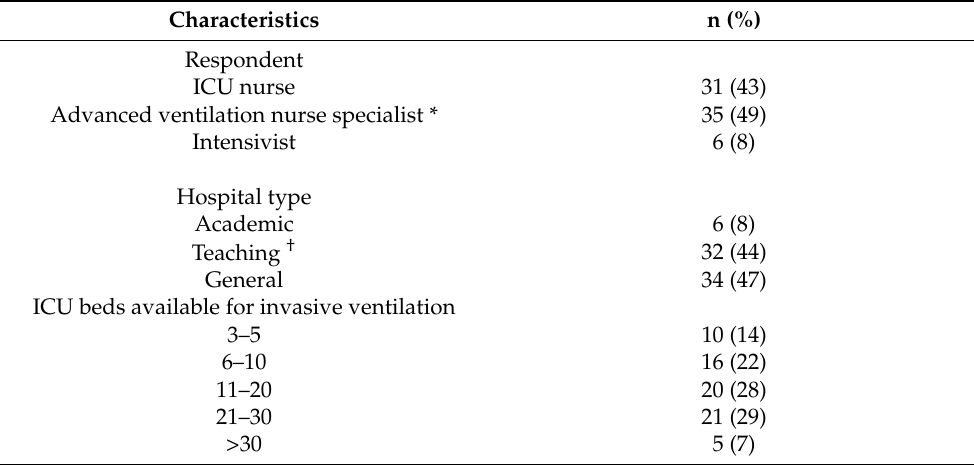
Table 1. Demographic characteristics of respondents and Dutch ICUs (N = 72).